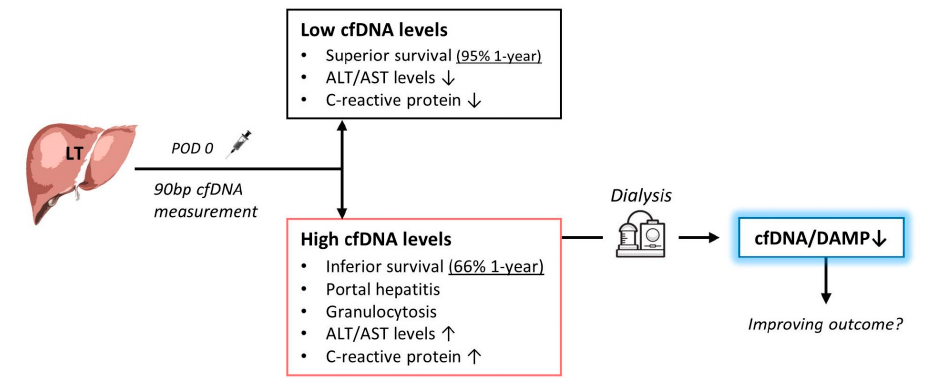
Figure 7. Schematic representation of the concept of using cell-free DNA (cfDNA) for the prediction of survival after liver transplantation and as a possible target in therapy. High levels of cfDNA in organ recipients are associated with a significantly poorer chance of survival. The cfDNA is a damage-associated molecular pattern (DAMP) that causes increased inflammation and lobular hepatitis in organ donors. Immediate measurement after liver transplantation can identify patients with high cfDNA levels. By using haemodialysis with haemofiltration and/or haemoadsorption, these DAMP could be filtered out of the blood to potentially improve the prognosis after liver transplantation.